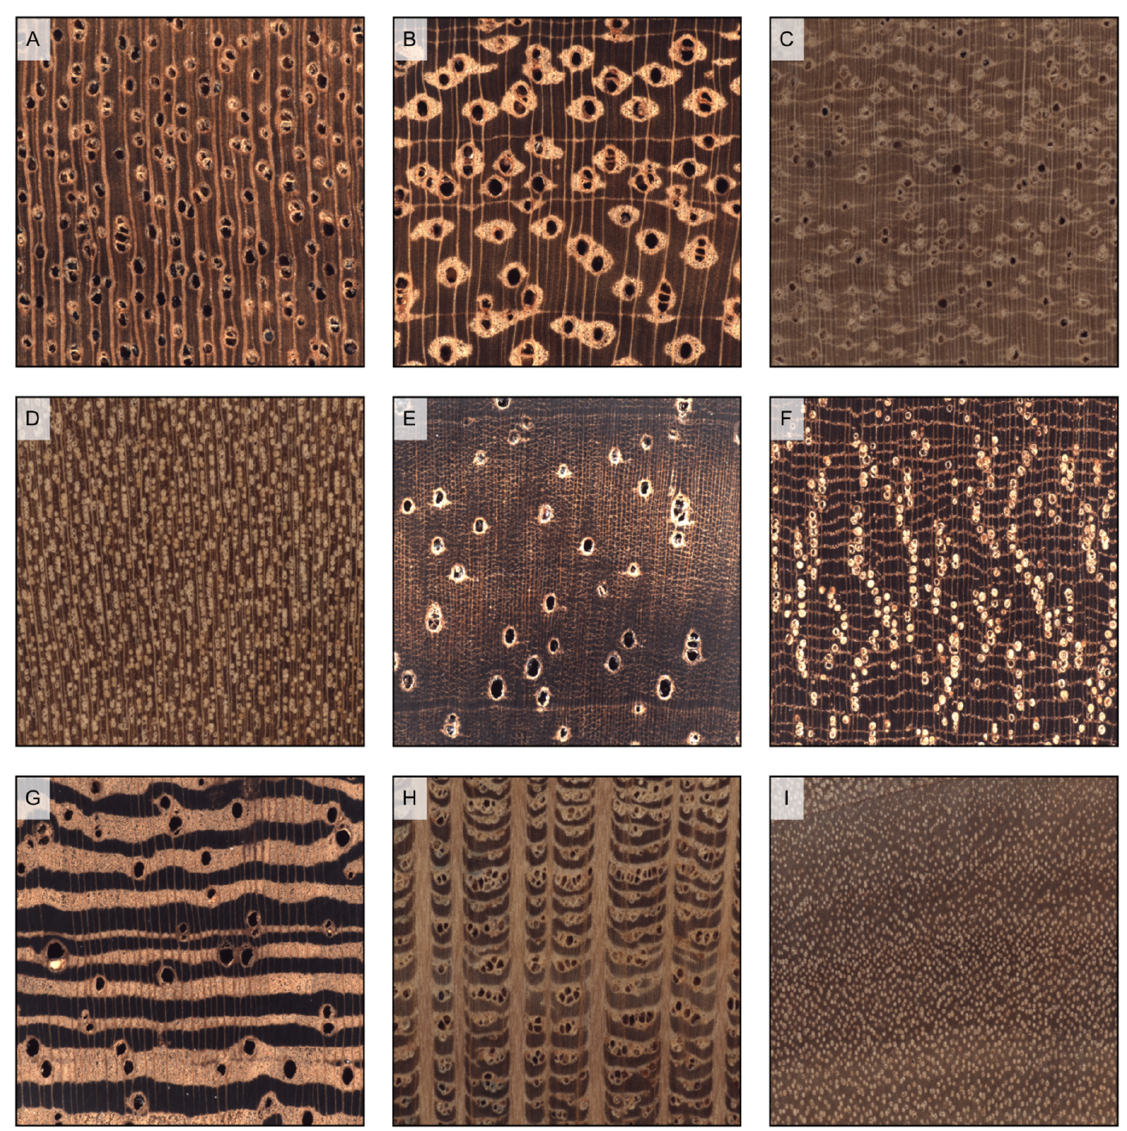
Figure 8. Axial parenchyma distribution in hardwoods (transverse sections). ( A ) vasicentric ( Khaya ivorensis ); ( B ) lozenge-aliform, confluent, and in marginal or seemingly marginal bands ( Afzelia bipindensis ); ( C ) winged-aliform and confluent ( Gonystylus bancanus ); ( D ) diffuse ( Alstonia macrophylla ); ( E ) diffuse-in-aggregates and vasicentric ( Dalbergia retusa ); ( F ) narrow bands and reticulate ( Autranella congolensis ); ( G ) wide bands ( Millettia laurentii ); ( H ) festooned and scalariform ( Grevillea robusta ); ( I ) absent ( Salix alba